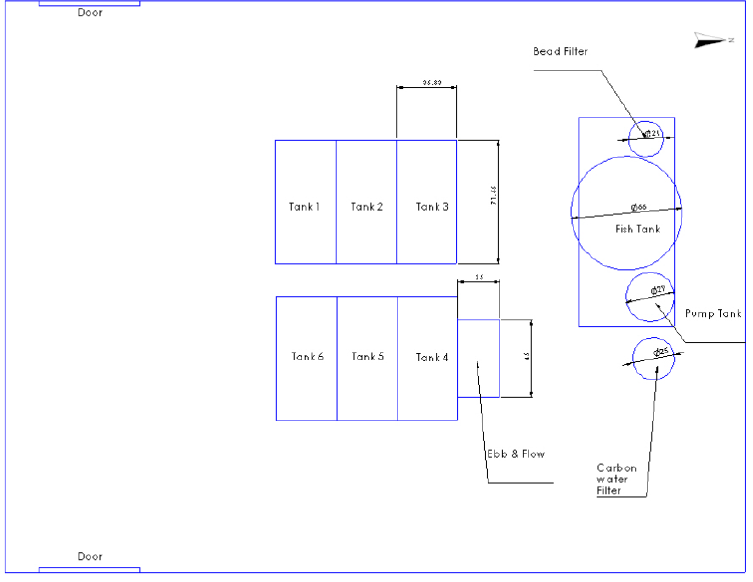
Figure 1. Greenhouse experiment floor plan (drawn to scale). Table 2. Experimental physical arrangement by trial and block.